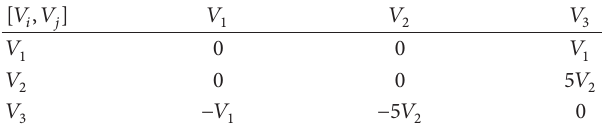
Table 1: Commutator table of the Lie algebra of (1.2).